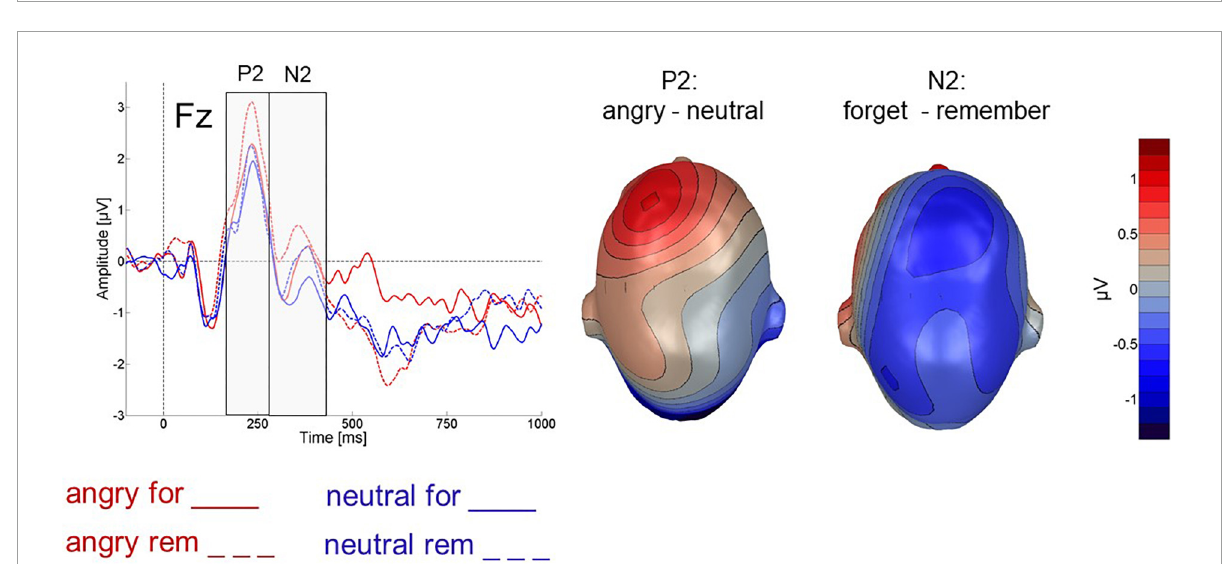
FIGURE4 Left: Cue-evoked ERP for cues following angry (red) and neutral (blue) faces at electrode Fz. Right: Difference topography for angry minus neutral faces across all 64 electrodes for the P2 and N2 time-windows highlighted on the left.